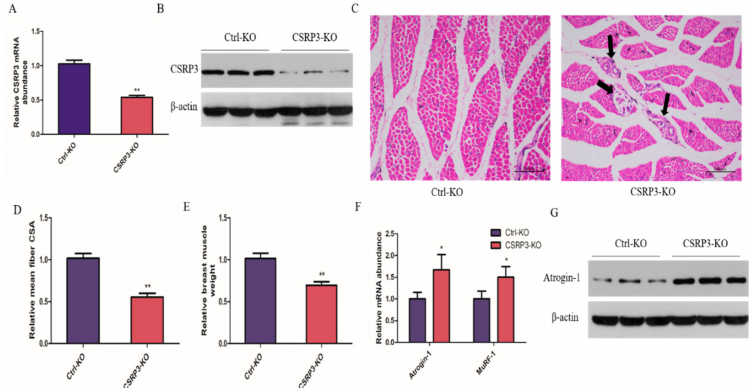
Figure 1. CSRP3 regulates mean muscle fiber and muscle mass in chicken skeletal muscles. ( A and B ) CSRP3 mRNA and protein expression in breast muscle after lentivirus injected. Hematoxylin and eosin (H&E) staining ( C ), mean muscle fiber CSA, scale bar = 100 µ m (Black arrows point to necrotic myofibers) ( D ), and muscle weight ( E ) of breast muscle fiber cross-section after lentivirus injected. ( F and G ) Atrogin-1 and MuRF-1 mRNA expression and Atrogin-1 protein expression in breast muscle after lentivirus injected. Data are expressed as mean ± SEM of three independent experiments. * p < 0.05, ** p <